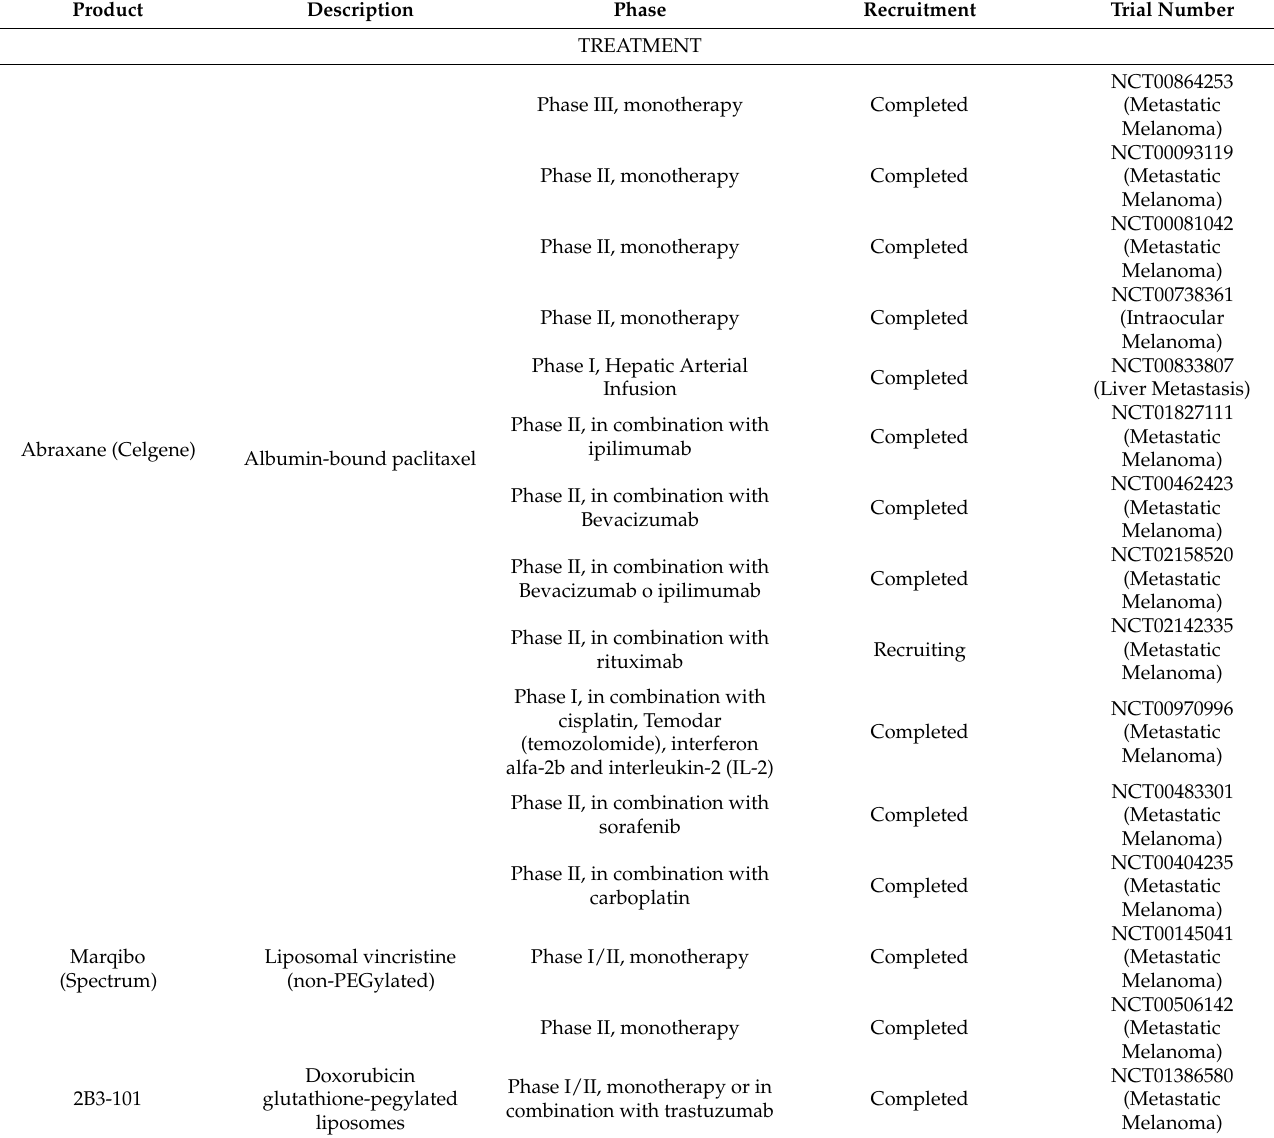
Table 1. Nanotechnology products under clinical evaluation for melanoma